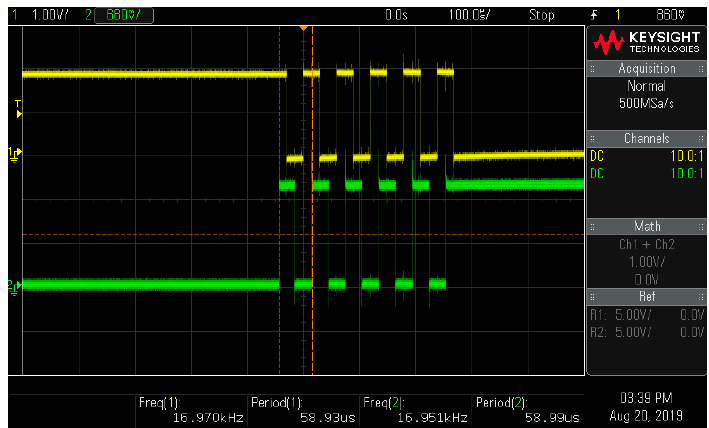
Figure 9. The logical levels of the acknowledge (ACK) signals (Yellow: downlink, Blue: uplink) during transmission at the maximum speed.